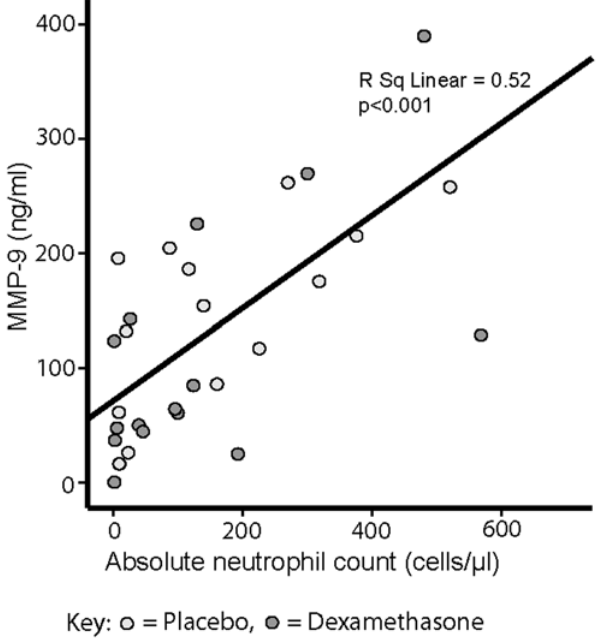
Figure 3. CSF MMP-9 concentration and CSF neutrophil count are significantly correlated in early follow up samples. Early follow-up CSF samples, taken a median of 5 days (range 3–8, n=29) into anti-tuberculosis treatment, from patients with tuberculous meningitis were analyzed for correlation between absolute neutrophil count and MMP-9 concentration (measured by ELISA). The R 2 value for the correlation was 0.52 (p , 0.001). Patients who received placebo are represented by light grey circles and dexamethasone by dark grey circles.